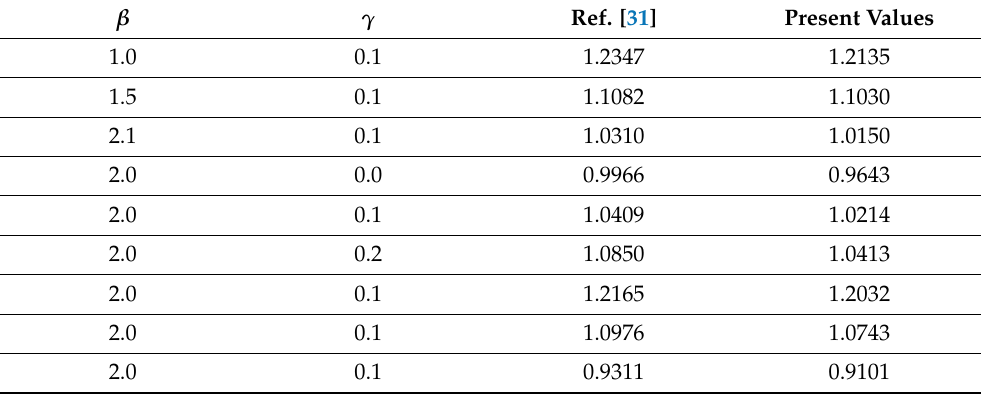
Table 16. Comparison of skin friction coefficient with Ref. [31].